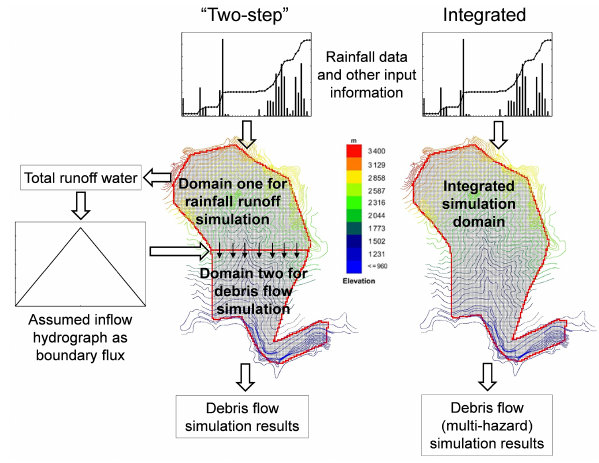
Figure 1. Comparison between “two-step” simulation and inte- grated simulation of rain-induced debris